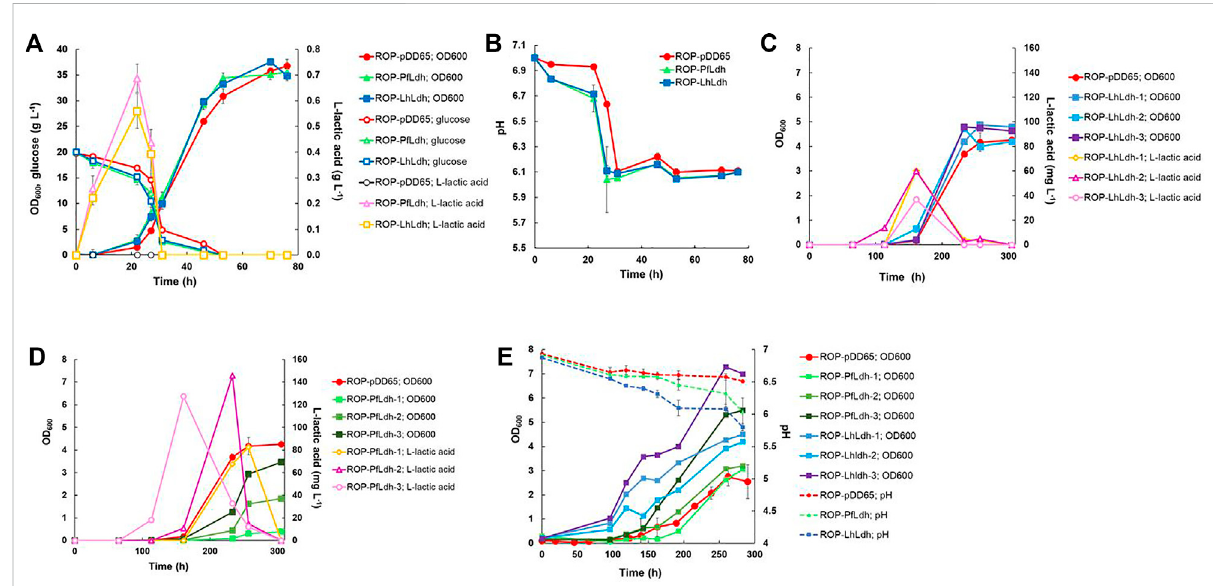
FIGURE 3 Heterotrophic and autotrophic production of L-lactic acid and biomass by derivatives of R. opacus strain DSM 43205 containing genes encodingeitheralactatedehydrogenaseof L.helveticus (Lh ldh )or P.falciparum (Pf ldh ).Heterotrophicshake- fl askcultivations (A,B) wereperformed inDSM-81 medium supplemented with 20 g L − 1 glucose and glucose and lactic acid concentration as well as cell density (OD 600nm ) (A) and pHwere monitored (B) . Sub fi gures (A) and (B) display average of biological triplicates with standard deviations. L-lactic acid concentration, pH change, andcellgrowth weremonitoredduringautotrophiccultivationsoftransformantsof R.opacus strainsROP-LhLdh (C) andROP-PfLdh (D) and,dueto large differences between the individual measurements, are displayed in separate sub fi gures and as individual measurements for clarity. Changes in cell density (OD 600nm ) and pH during autotrophic electrobioreactor cultivations of R. opacus strains ROP-LhLdh and ROP-PfLdh are shown in sub fi gure (E) R.opacus pDD65isincludedasacontrolstrainanddatapointsrepresentaveragesoftriplicatemeasurementswitherrorbarsindicating the standard deviation.